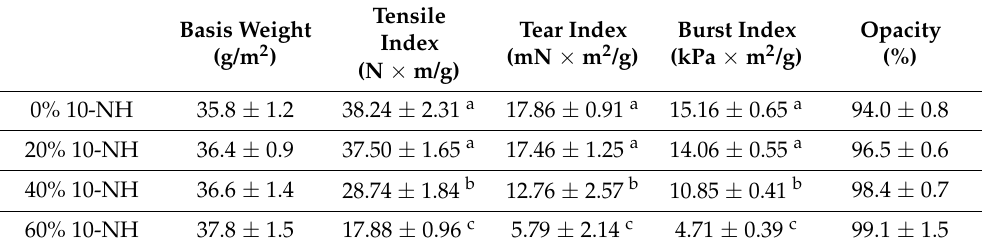
Figure 8. Visual appearance of 0%, 20%, 40%, and 60% 10-NH mixed pulp handsheets. Table 3. Mechanical properties of 0%, 20%, 40%, and 60% 10-NH mixed pulp handsheets . Basis Weight Tensile Index Tear Index Burst Index Opacity